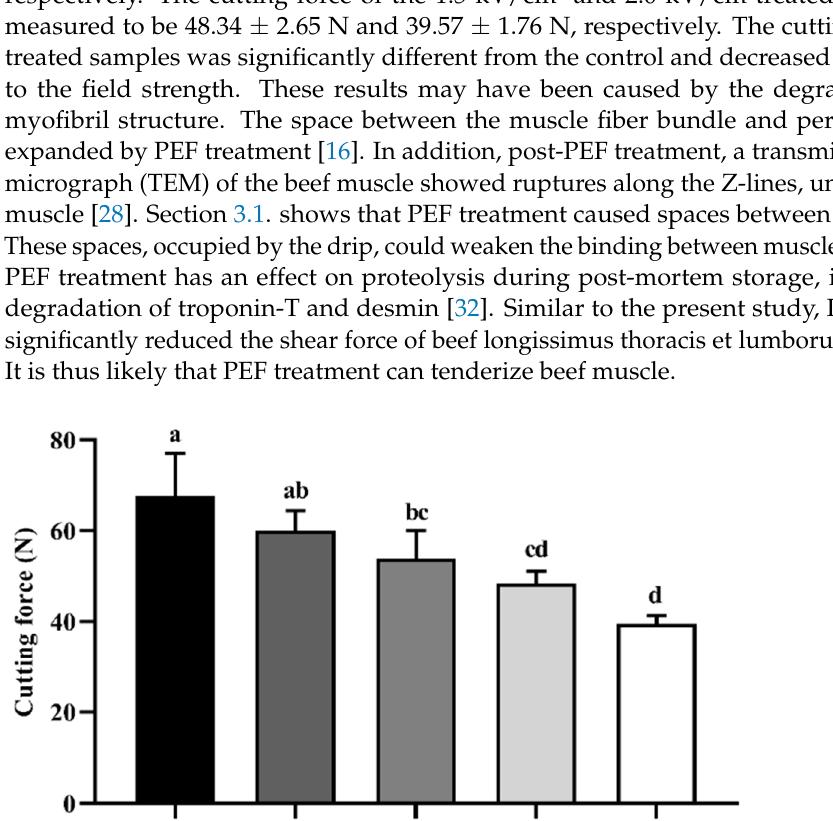
Table 1. Texture profile analysis (TPA) of PEF-treated beef at different field strengths.